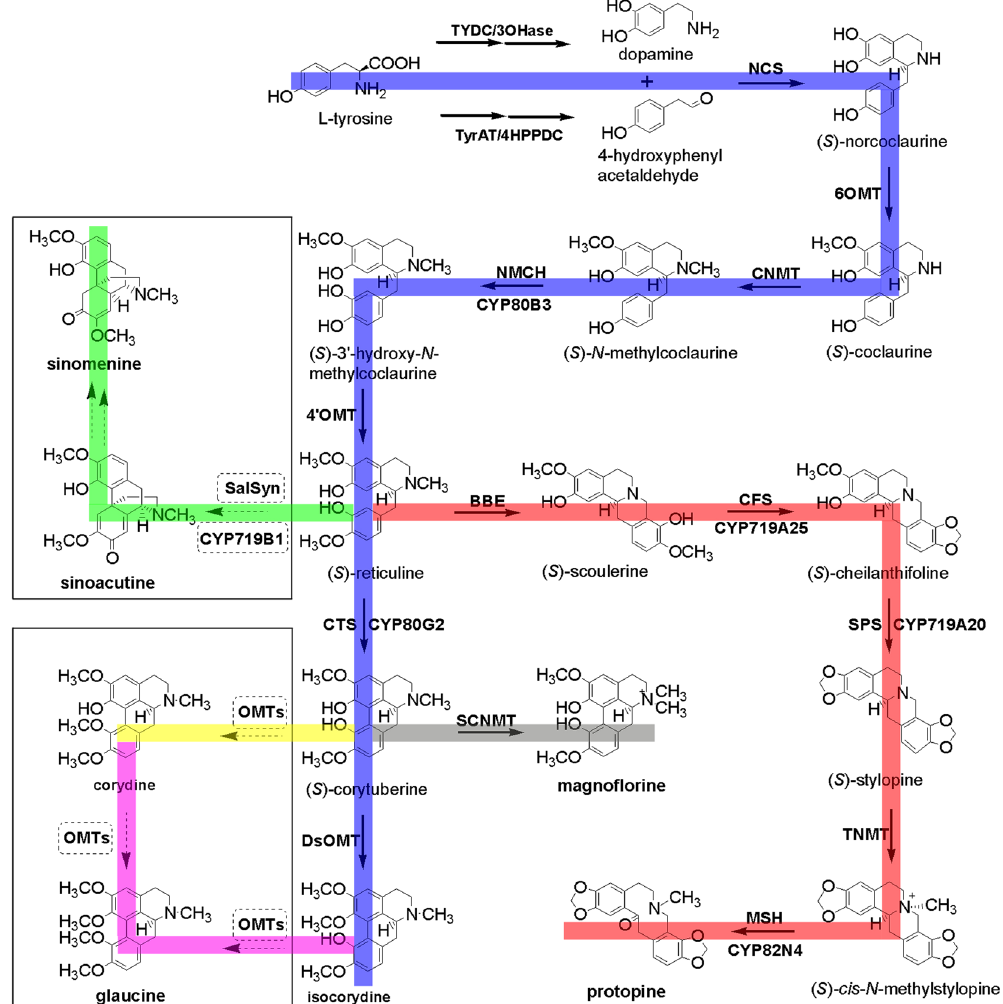
Figure 3. Putative pathways for IQAs biosynthesis in D . scandens . Enzymes found in this study are boxed. Abbreviations: TyrAT, L-tyrosine aminotransferase; 4HPPDC, 4-hydroxyphenylpuruvate decarboxylase; TYDC, tyrosine decarboxylase; 3OHase, tyrosine/tyramine 3-hydroxylase; NCS, ( S )-norcoclaurine synthase; 6OMT, norcoclaurine 6- O -methyltransferase; CNMT, ( S )-coclaurine N-methyltransferase; NMCH, N - methylcoclaurine 3 ′ -hydroxylase; 4 ′ OMT, 3 ′ -hydroxy- N -methylcoclaurine 4 ′ - O -methyltransferase; BBE, berberine bridge enzyme; CFS, ( S )-cheilanthifoline synthase; SPS, ( S )-stylopine synthase; TNMT, ( S )- tetrahydroprotoberberine N -methyltransferase; MSH, ( S )- cis - N -methylstylopine 14-hydroxylase; CTS, corytuberine synthase; SCNMT, ( S )-corytuberine- N -methyltransferase; SalSyn, salutaridine